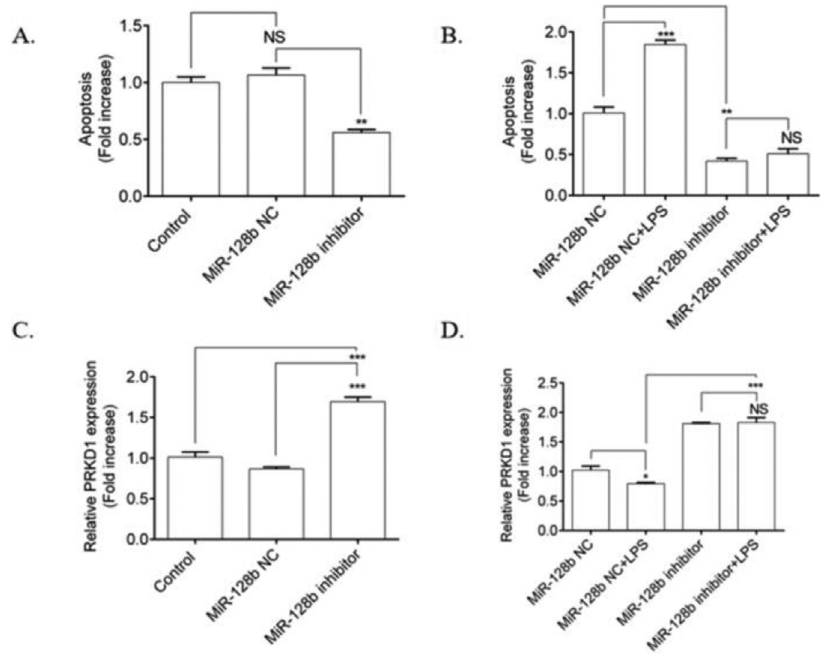
Figure 3. (A-) Detection of human pulmonary microvascu- lar endothelial cell (HPMEC) apoptosis via FCM analysis. HPMECs were treated with Lipopolysaccharide (LPS) (1 μ g/mL) for 24 h. Apoptosis was analyzed via FCM analy- sis. Apoptotic cells were de fi ned as annexin V- and PI-posi- tive cells. (C, D) Expression levels of PRKD1